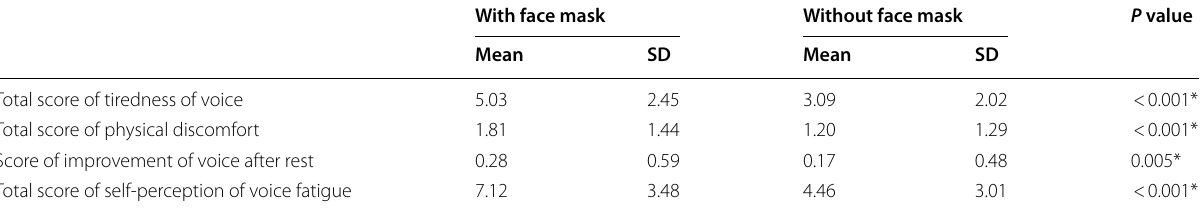
* Significant p value < 0.05, SD standard deviation